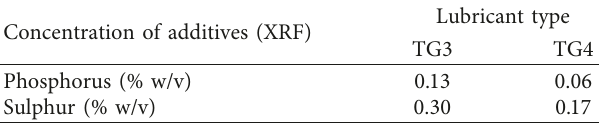
Table 2: Concentration of additives in lubricants. Concentration of additives (XRF)